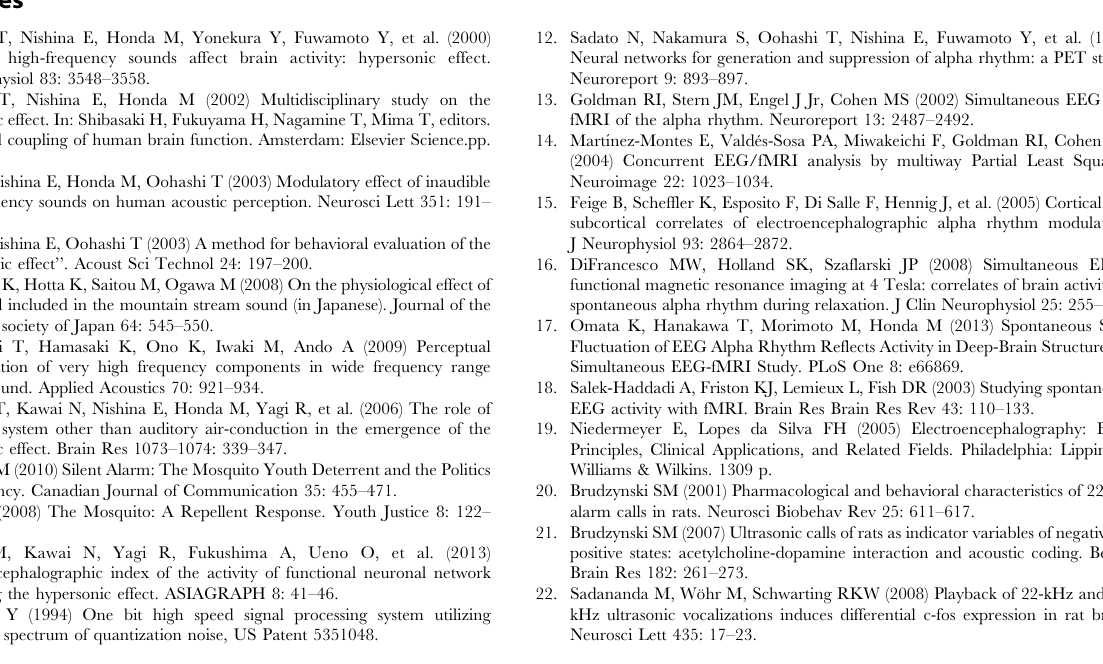
Figure S1 The powers of the applied sound stimuli and the change of Alpha-2 EEG. To examine whether the